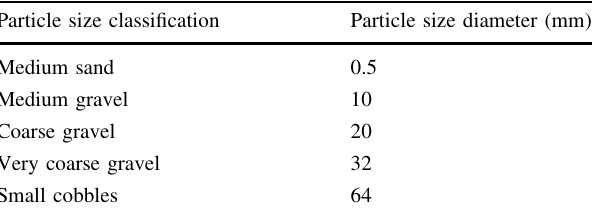
Table 1 Median soil particle sizes and classification used in potential erosion estimates Source: Julien (1995) Particle size classification